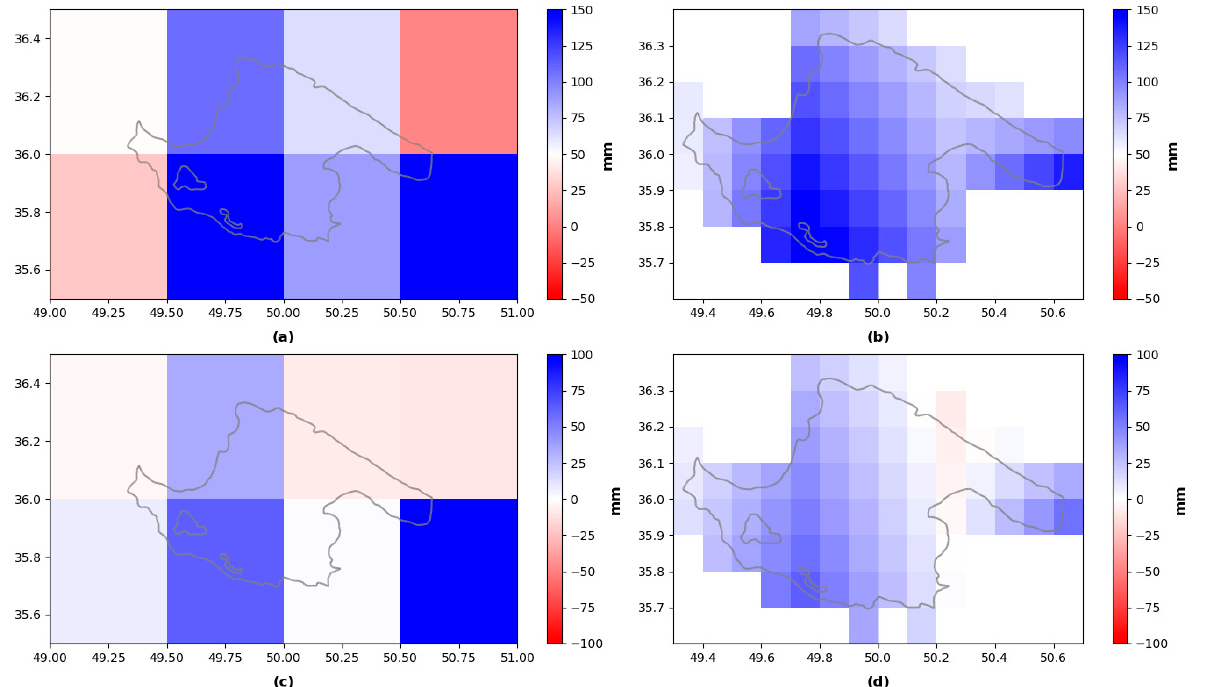
Figure 4. Spatial distribution of GWSA before and after the downscaling; ( a , c ) the original 0.5-degree WGHM-GWS data on Apr 2010 and Aug 2010; ( b , d ) the downscaled product at 0.1 degrees in the same month.